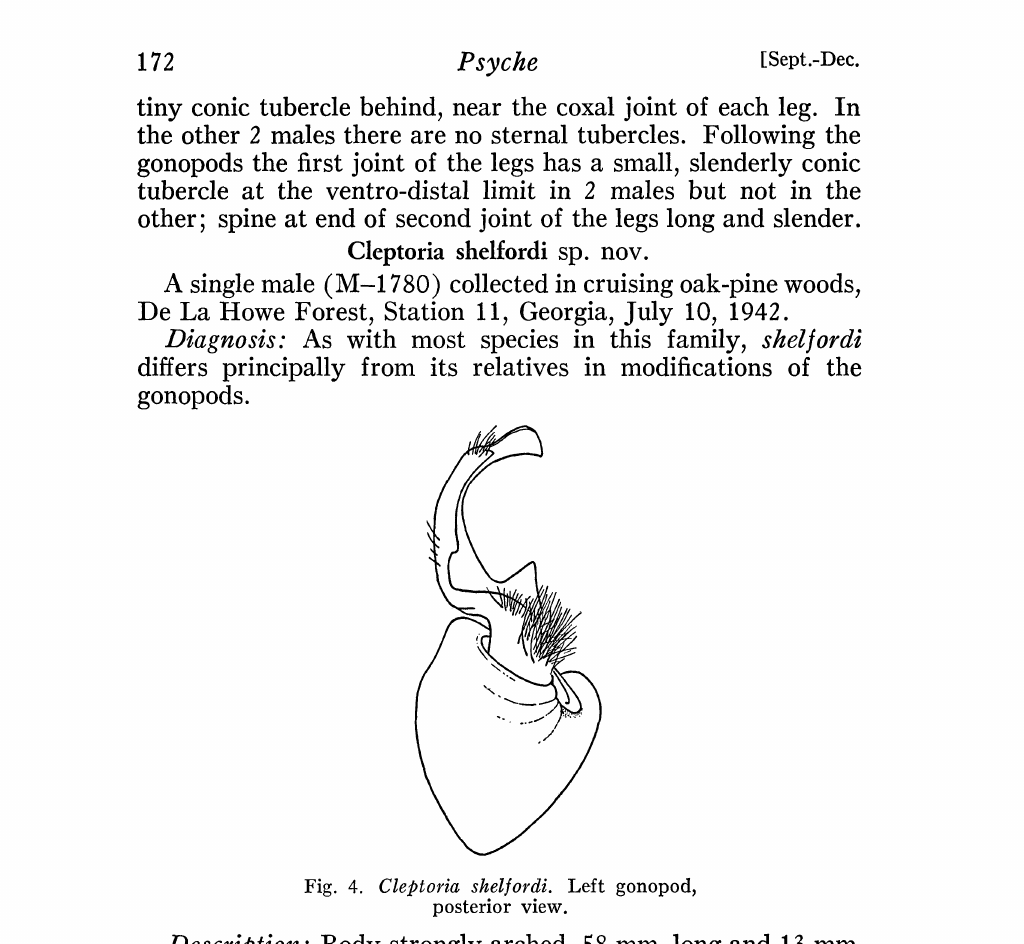
Fig. 4. Cleporia shelJordi. Left gonopod posterior view. Descriptioe" Body strongly arched, 58 mm. long and 13 mm. wide; posterior edge of lateral keels slightly overlapping the anterior edge of the ensuing ones; dorsal surface finely coria-